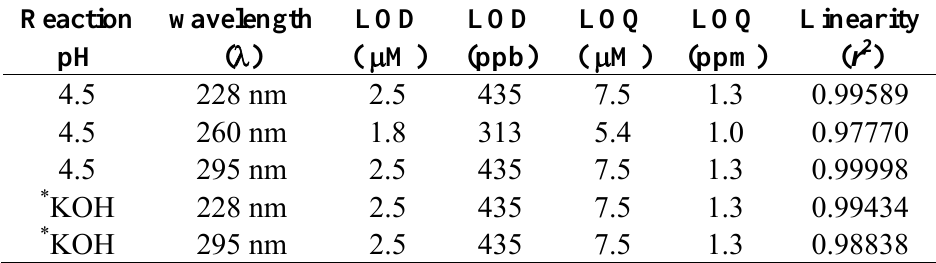
Table 1. Unmodified CA limits of detection (LOD) and quantitation